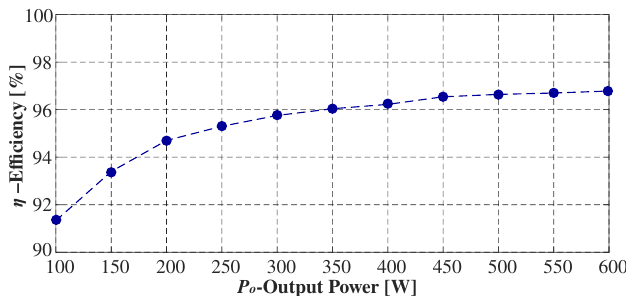
Figure 14. Experimental efficiency curve.